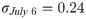
The degree-of-freedom of the awning shades (σJuly6=0.24) is more often activated than the venetian shades (σJuly6=0.06) and the spherical tracker (σdof1-July6=0.11,σdof2-July6=0.31).